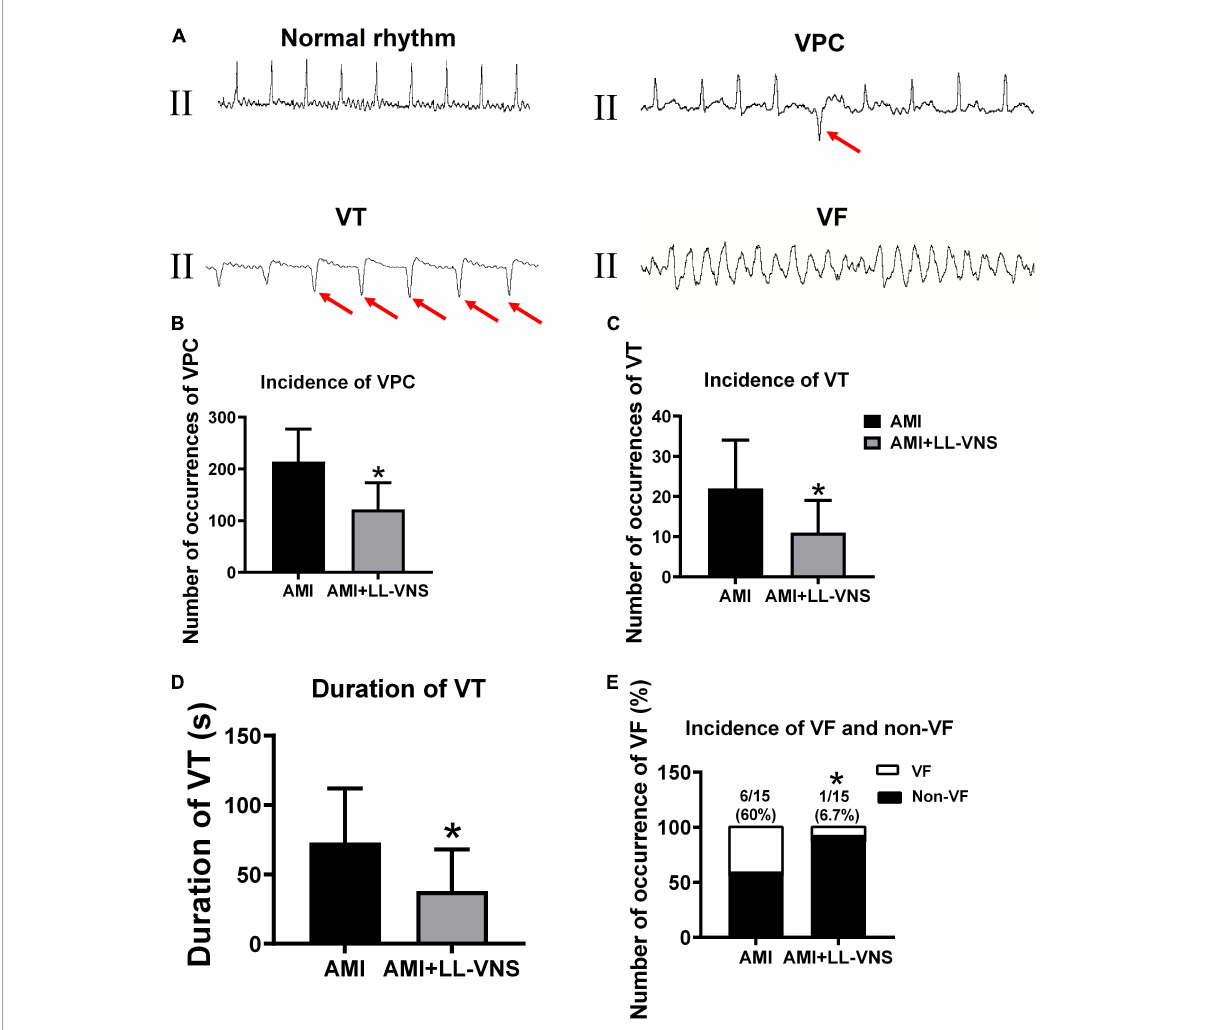
FIGURE5 The occurrence of ventricular arrhythmias after complete occlusion of the left anterior descending branch. (A) ECG traces representing typical examples of VAs, including VPC, VT, and VF. (B) Comparison of the incidence of VPC throughout the entire 60 min between the AMI group and the AMI + LL-VNS group. (C) LL-VNS decreased the incidence of VT within 60 min after AMI. (D) LL-VNS shortened the duration of episodes of VT occurring within 60 min after AMI. (E) LL-VNS reduced the incidence of spontaneous VF. AMI, acute myocardial infarction; ECG, electrocardiogram; LL-VNS, low-level vagus nerve stimulation; VF, ventricular fibrillation; VPC, ventricular premature contraction. n = 15 per group. * P < 0.05 in a comparison with the AMI